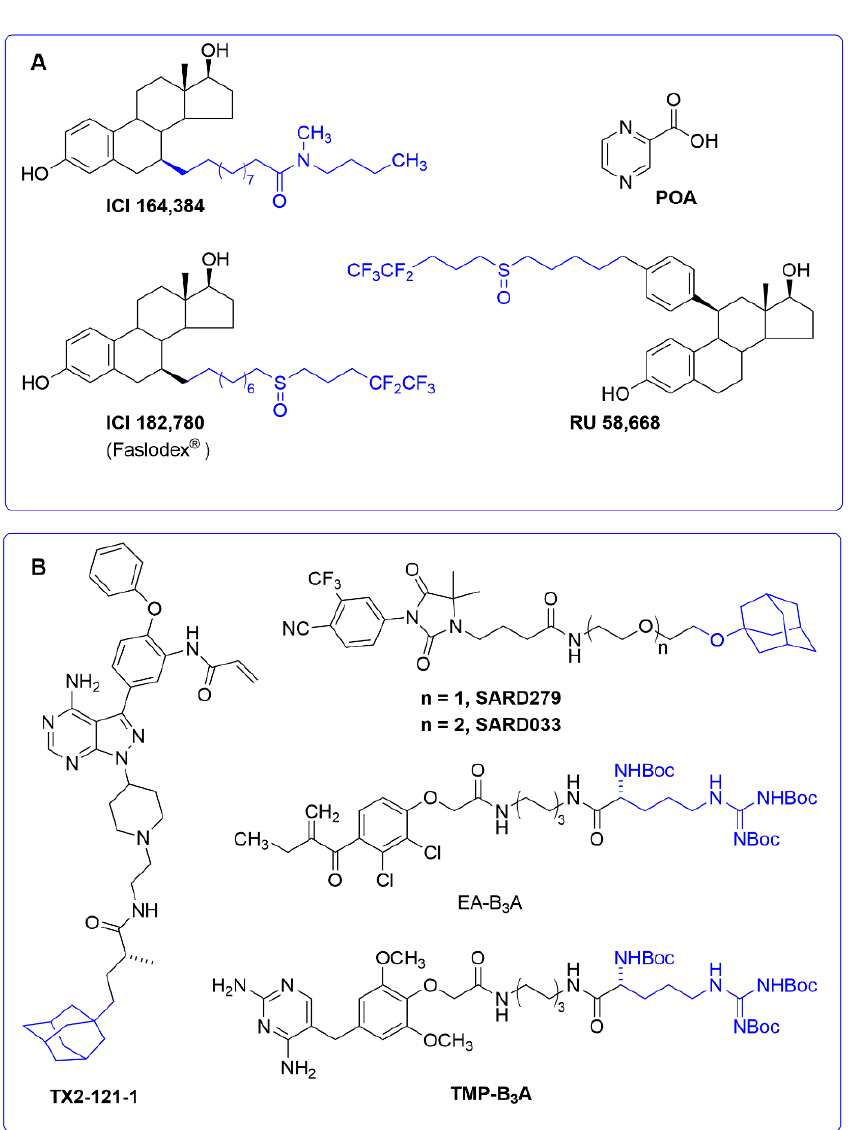
Figure 7. ( A ) Structures of pyrazinoic acid (POA) and selective estrogen receptor down-regulators (SERDs). ( B ) Examples of adamantyl and Boc3Arg as hydrophobic tags. Hydrophobic tags are shown in blue.